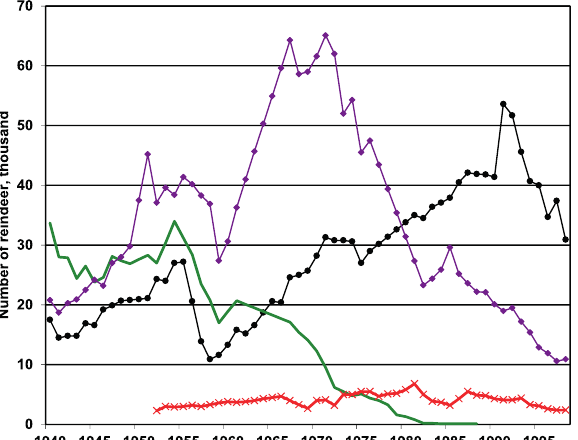
Fig. 4. Domesticated reindeer populations (in thousands) in different ethno-economic areas of the Taimyr Autuono- mous okrug; Nenets’ ( ―● ), Nganasan’s ( ― ), Dolgan’s ( ―♦ ), and Evenk’s ( ―˟ ). Within several local ethno-economic areas of the same administrative district, reindeer populations vary greatly. The sharp rise in the wild reindeer population in the central part of Taimyr resulted both in the complete loss of reindeer husbandry in the Nganassan area and in the depression of reindeer husbandry in the Dolgan area. By contrast, the domesticated reindeer numbers in the Nenets area situated on the West of the Enisei River increasd in the 1970s and 1980s. The number of domesticated reindeer in the Evenki area (in the Lake Khantaika basin, situated in the southern part of Taimyr) has gradually decreased since